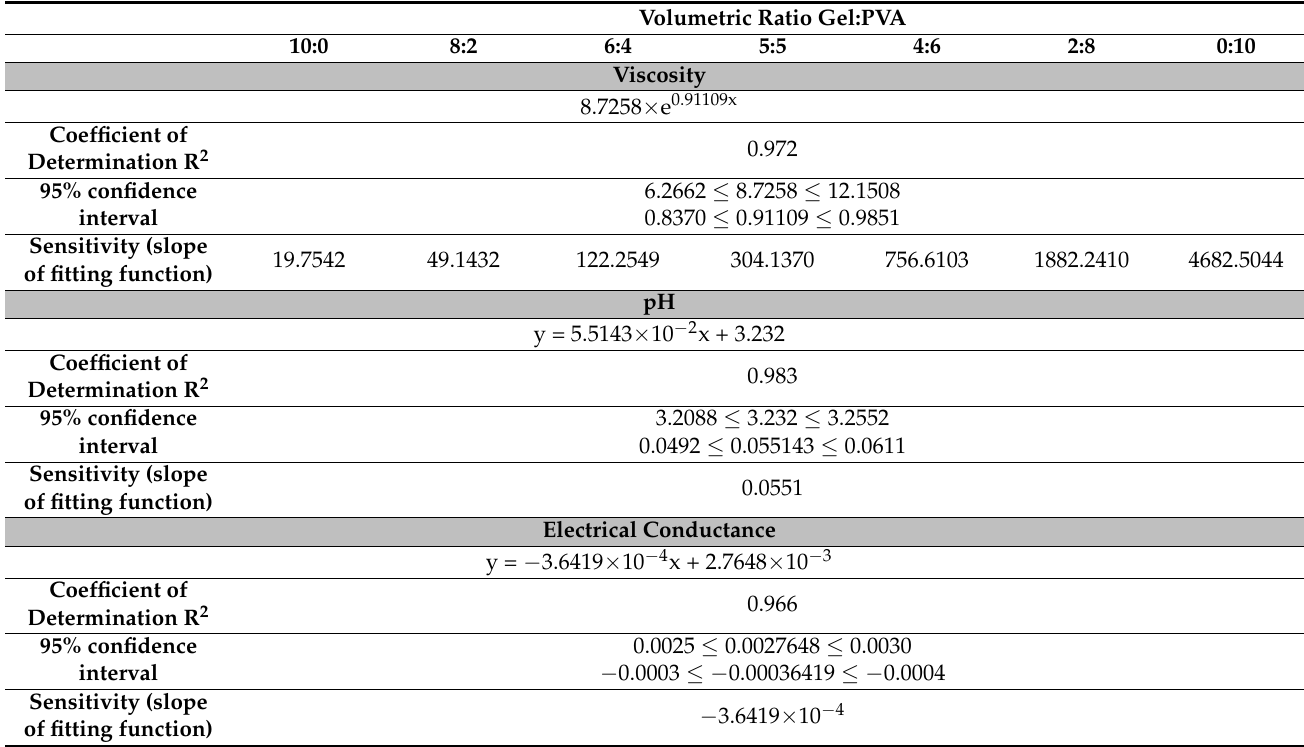
Table 3. Statistical information of the fitting functions for the measurements of viscosity, electrical conductance, pH values, and surface tension of different gelatin/PVA mixed